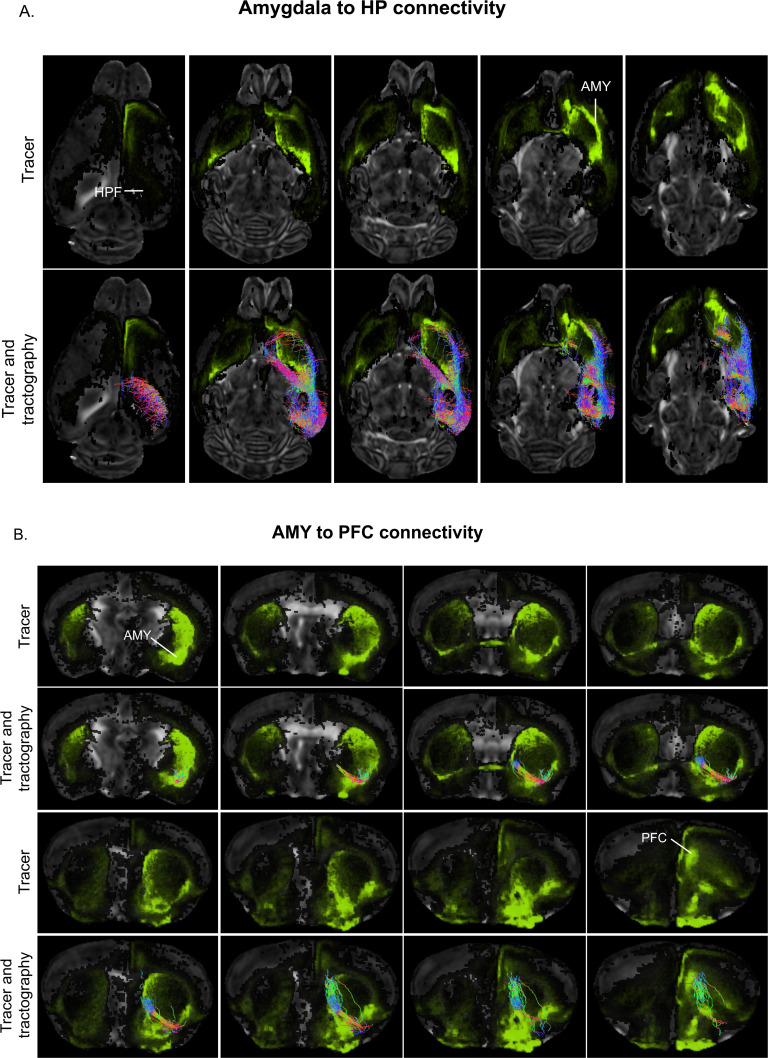
dMRI tractography shows good agreement with the anterograde tracing reported by the Allen Mouse Brain Connectivity Atlas (AMBCA) (Oh et al., 2014).Out of 2918 anterograde tracers injected in the right hemisphere, we selected an experiment that shows brain-wide axonal projection maps from the amygdala (AMY; ID: 113144533) and hippocampus (ID: 100147861) and co-registered into each subject’s native space. Tractography-based connectivity patterns were then superimposed on tracer maps in the right hemisphere to justify the agreement between the estimated tracts and the ground truth. (A) AMY to hippocampus connectivity. (B) AMY to PFC. For each panel we show a row of images using the AMBCA anterograde tracer (AAV1-GFP, green) followed by a row showing dMRI tractography (blue–red) overlaid on top of the anterograde tracing. It is important to note that complete overlap is not expected as dMRI tractography examines tracks that are bi-directional vs. anterograde tracing seen with AAV-GFP (Maier-Hein et al., 2017, Pallast et al., 2020). In addition, the AMBCA tracing was done with AAV1 (Oh et al., 2014) which has some retrograde transport component (Murlidharan et al., 2014), further complicating the comparison with dMRI.